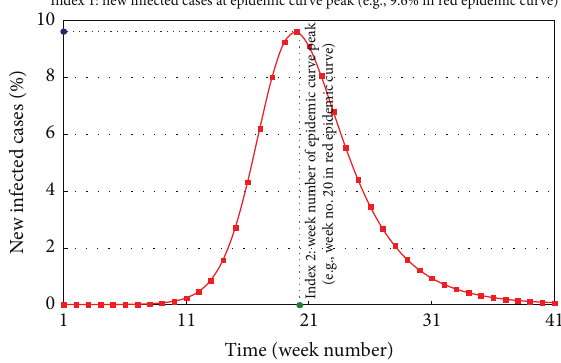
Figure 12: Dual-intervention policy evaluation index (peak num- bers of infected cases and time of peak).